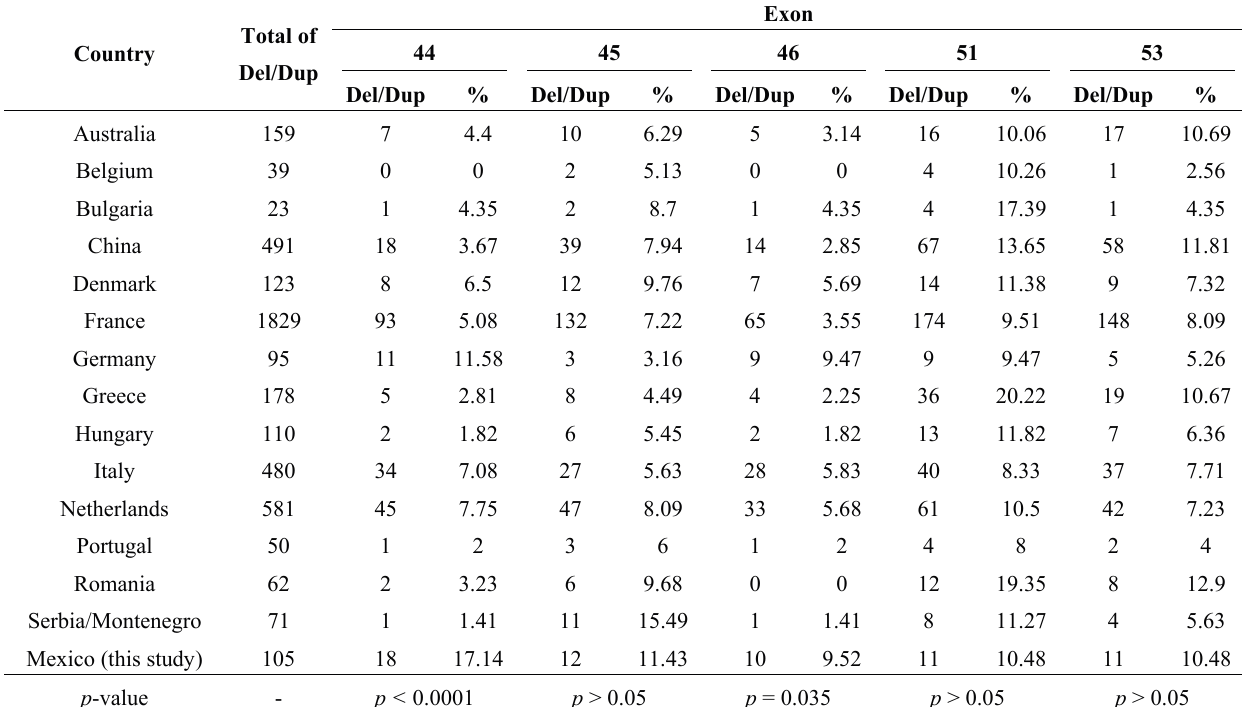
Table 3. Frequencies of applicable exon skipping targets among populations (inter-population